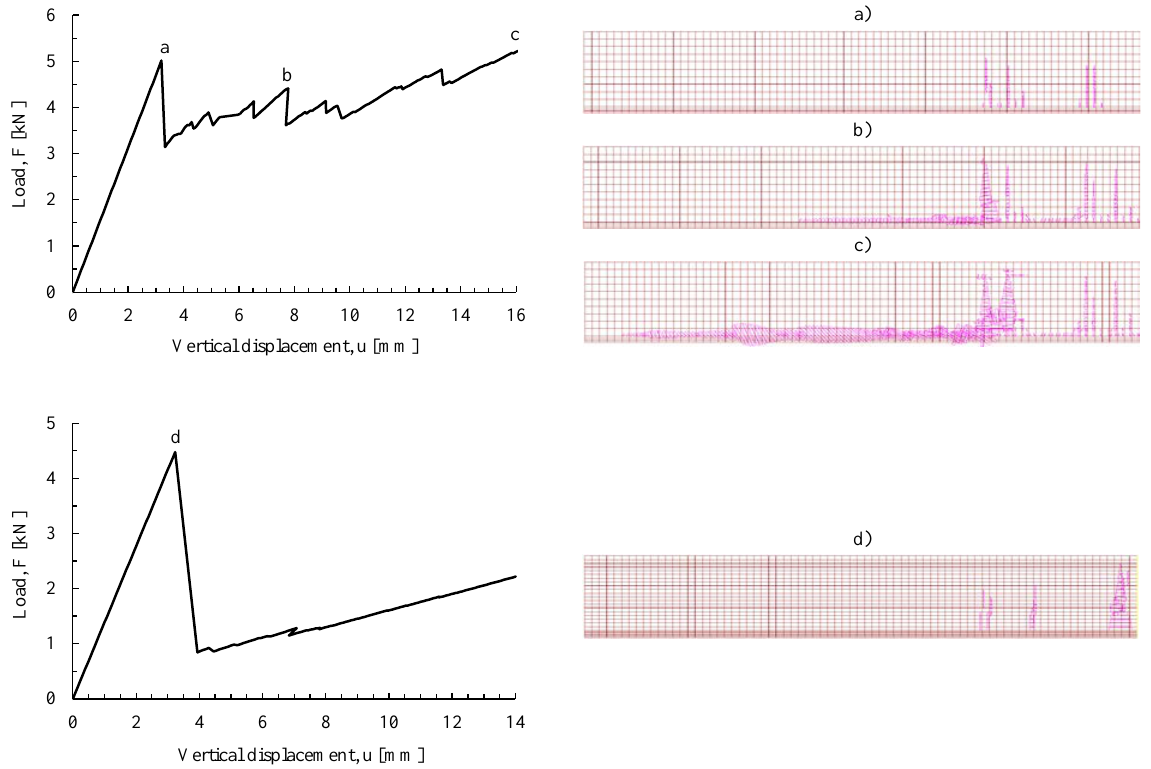
Fig. 3 Load vs . vertical displacement diagrams of the S Dur (top left side) and S Flex (bottom left side) beams, obtained from the FEMIX using a smeared crack model, as well as the crack pattern a), b), c) and d) at different phases (right side).